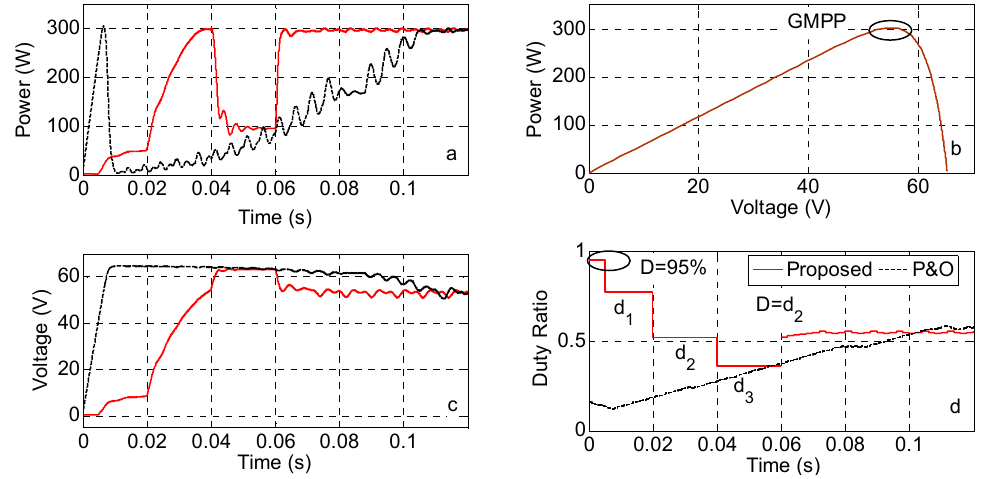
Figure 12. Case 3 ( a ) Voltage; ( b ) Power; ( c ) Duty Ratio; and, ( d ) Current.